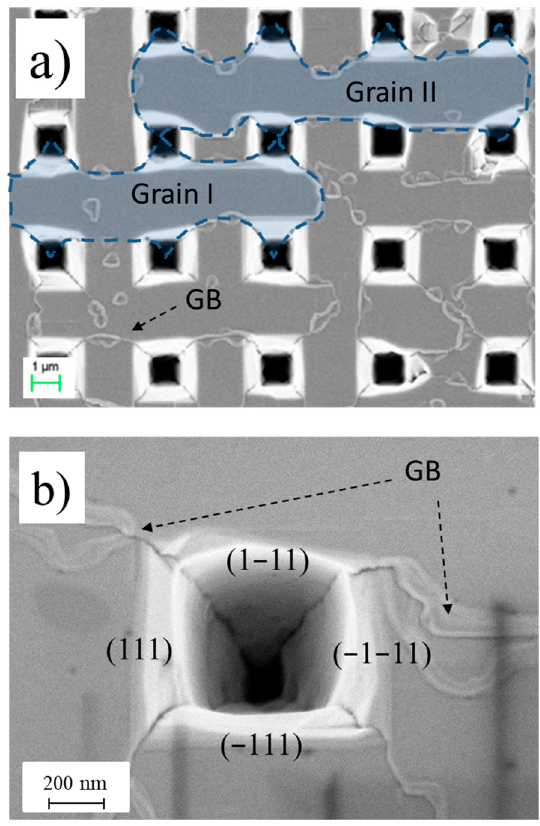
Figure 2. ( a ) Plan view SEM images of 2 μ m 3C-SiC film grown on 3 × 3 μ m 2 inverted silicon pyramids (ISP). As an example, the contour of two grains is highlighted in blue; ( b ) High magnification image of the pyramid showing GBs and pyramid faces.